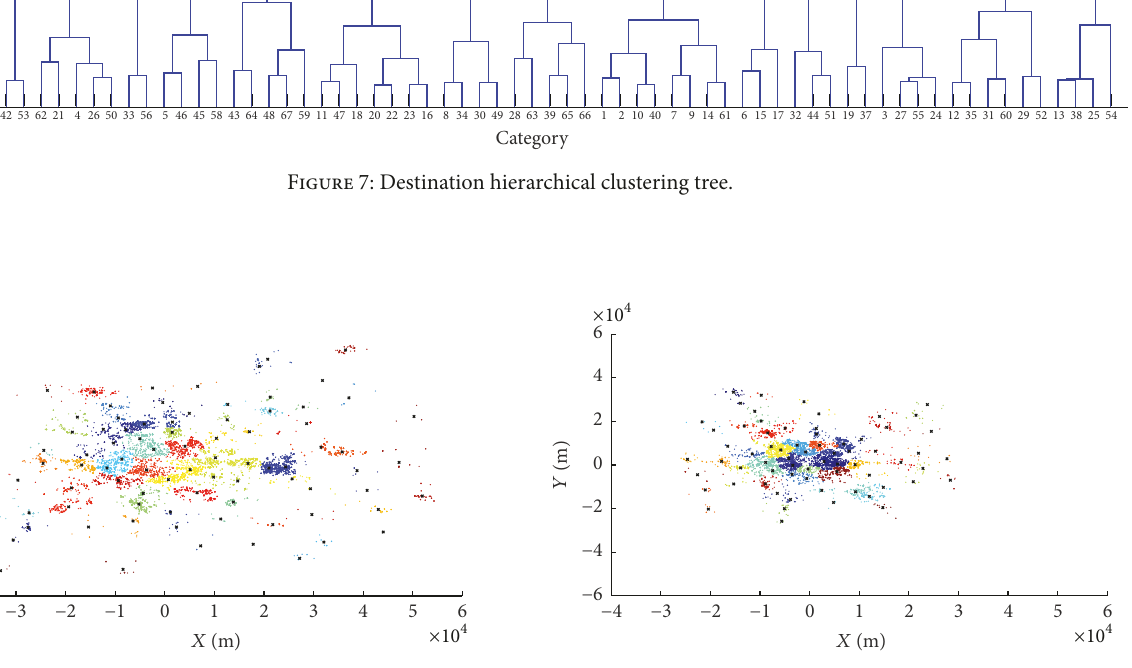
Figure 8: Origin hierarchical clustering diagram. Figure 9: Destination hierarchical clustering